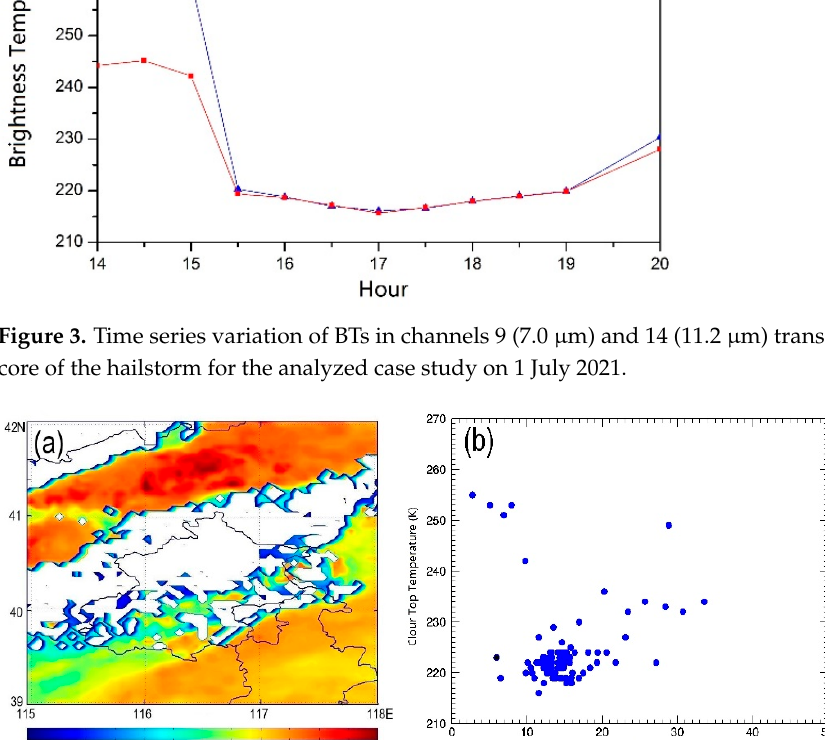
Figure 4. Spatial distribution of cloud-top height (CTH, unit: km) and the relationship between cloud-top temperature (CTT, unit: K) and cloud effective radius (CER, unit: μ m) retrieved from the Himawari-8 satellite over the Beijing region at 13:30 BJT on 1 July 2021. ( a ) CTH from Himawari-8 at 13:30 BJT on 1 July 2021; ( b ) CTT as a function of CER at 13:30 BJT on 1 July 2021 over the corresponding area in ( a ).